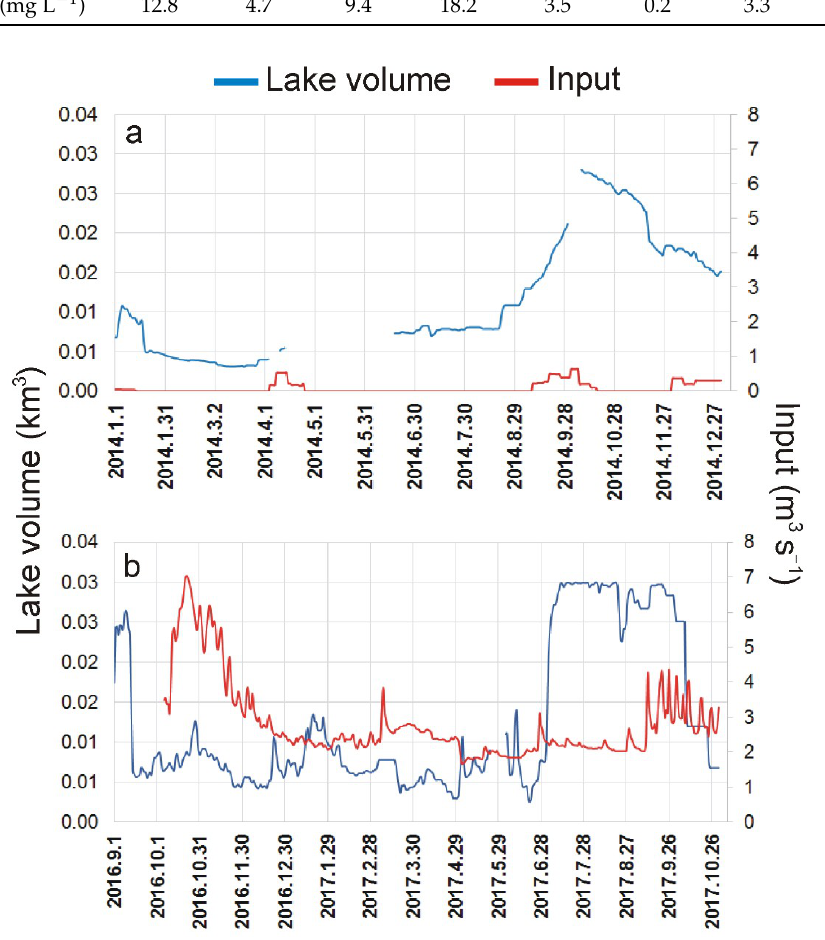
Figure 3. Lake volume and water input variations in the ( a ) La Salada and ( b ) Sauce Grande lakes during the study period. Input: water input.